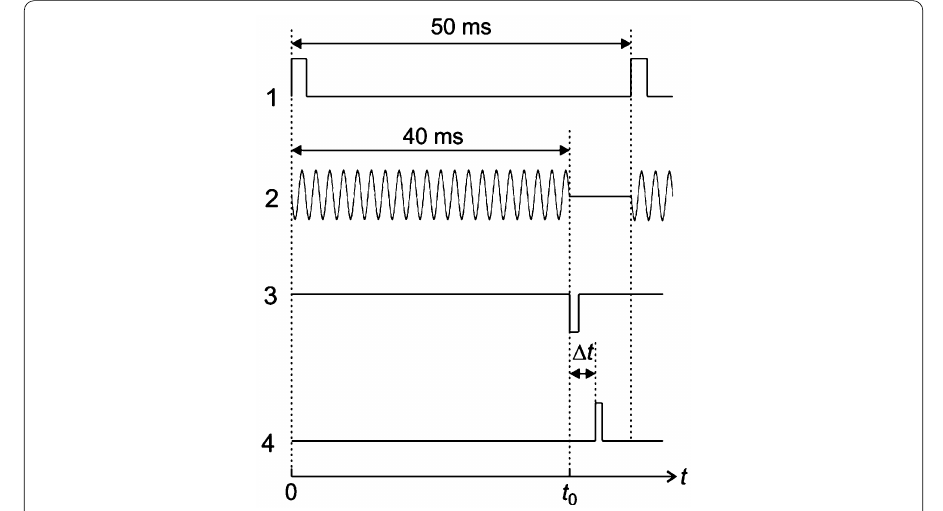
QIT exit end cap, (4) ion acceleration pulse for TOF-MS ( (cid:4) t , delay relative to unloading pulse of the ion trap). We defined (cid:4) t as the arrival